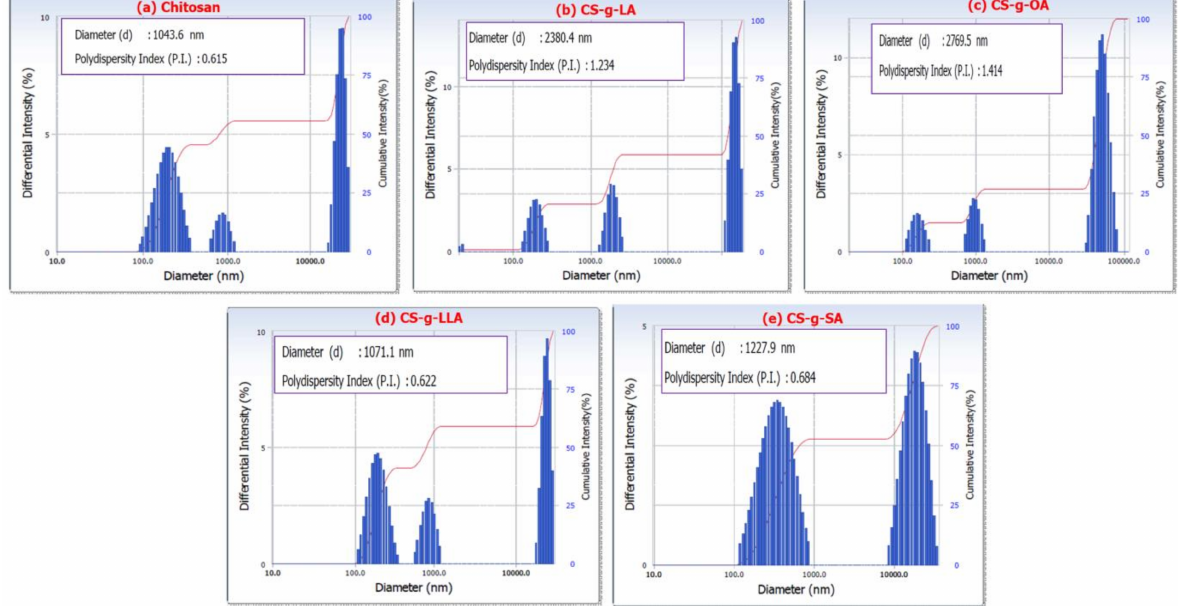
Figure 5. DLS measurements for pure CS and fatty-acid-modified CS in water solvent, ( a ) pure CS, ( b ) CS-g-LA, ( c ), CS-g-OA, ( d ) CS-g-LLA, and ( e )